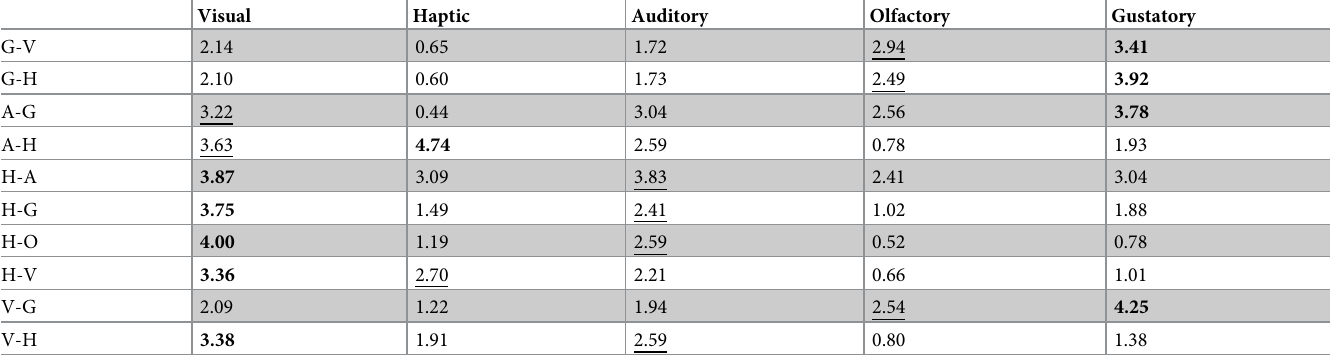
Table 8. Average of ratings for each combination of compounds.